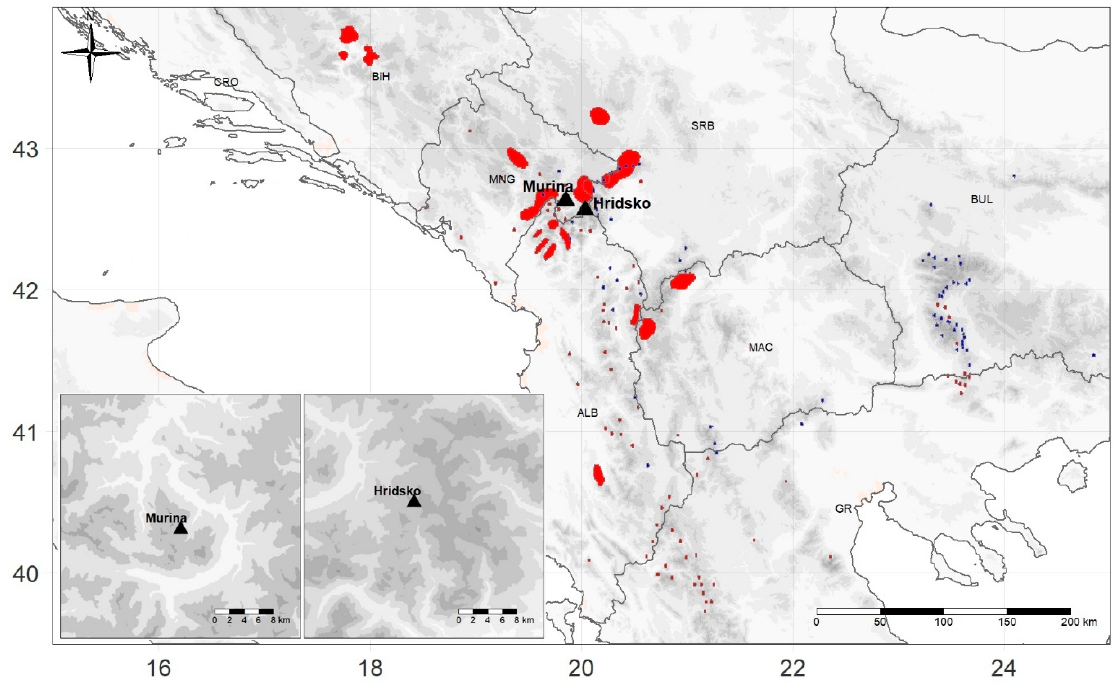
Table 1. Site characteristics and sample replication.